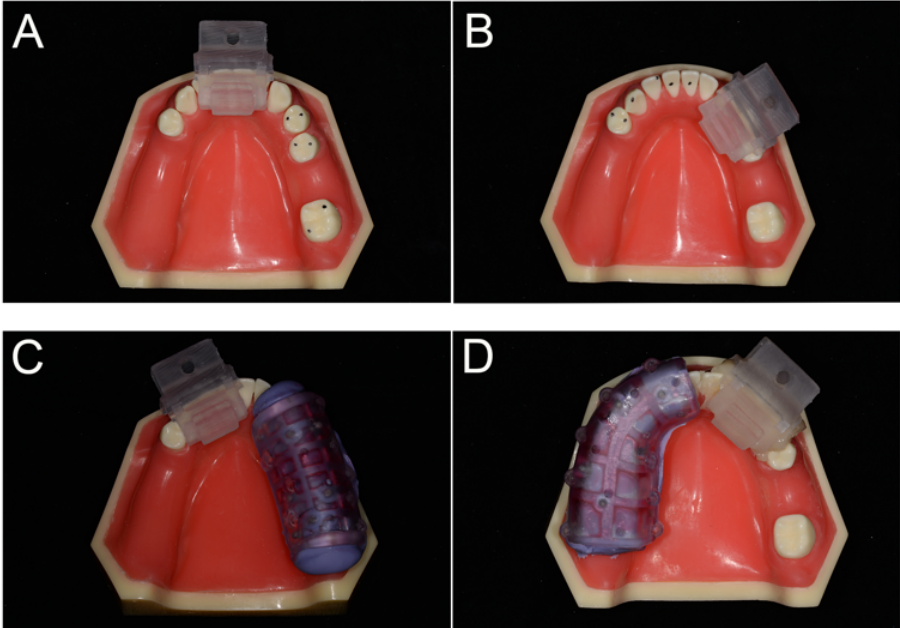
Figure 2. The model of the experiment and the grouping. ( A ) the cusp registration group, without distal-extension absence subgroup; ( B ) the cusp registration group, distal-extension absence sub- group; ( C ) the U-tube registration group, without distal-extension absence subgroup; ( D ) the U-tube registration group, distal-extension absence subgroup.